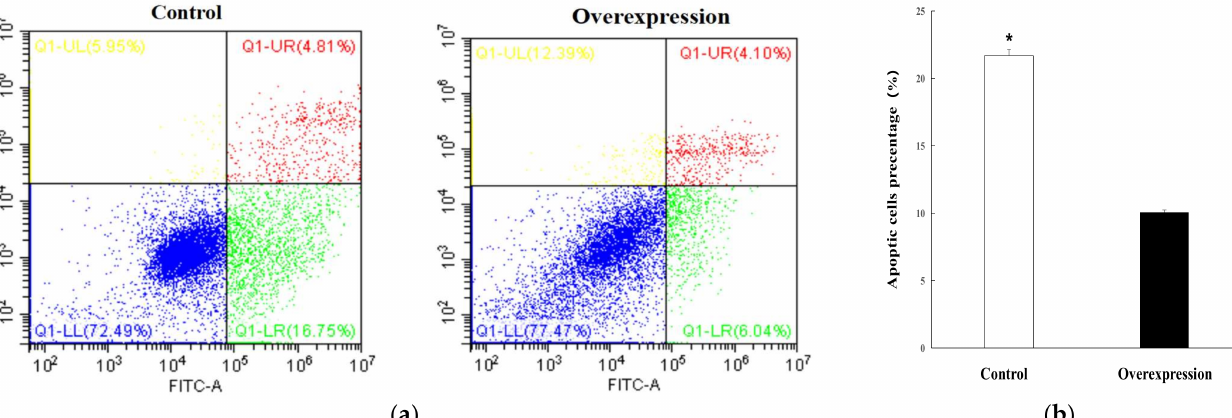
Figure 9. The effects of lnc_000884 overexpression on IPEC-J2 cell apoptosis. The data from three independent experiments was shown as means ± SEM. * p < 0.05. ( a ) The cells’ apoptosis detection by staining with FITC-Annexin; ( b ) the apoptotic cells percentages using a flow